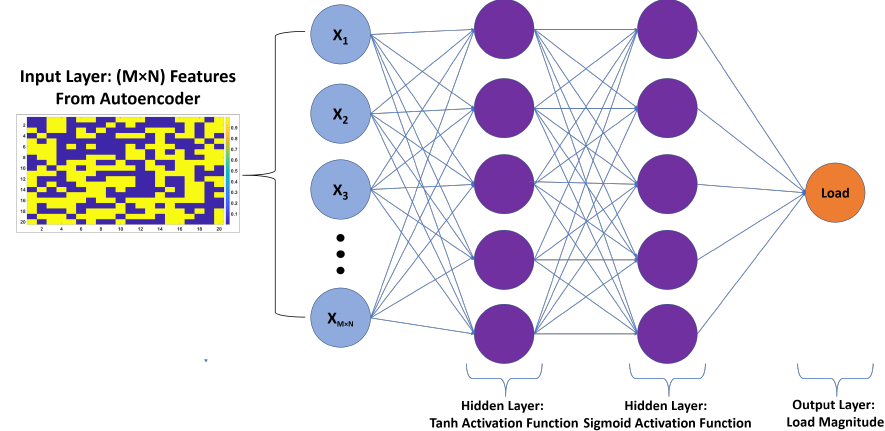
Figure 3. The proposed artificial neural networks (ANN) for estimation of loads with two hidden layers of tanh and sigmoid activation functions,